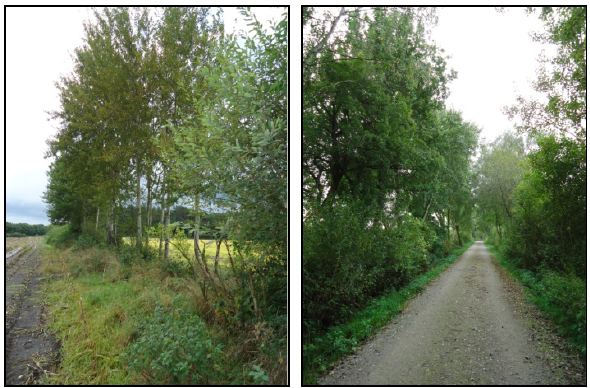
Figure 1. Examples of the vegetation used in our study: unploughed strips (left) and vegetation alongside streets (right) The general classification of ‘biomass’ is further separated into ligneous, graminaceous and herbaceous vegetation. Alignment with one of the three groups depends on the growth pattern, hedge type and size of the respective plants as well as the amount of biomass produced in a given temporal